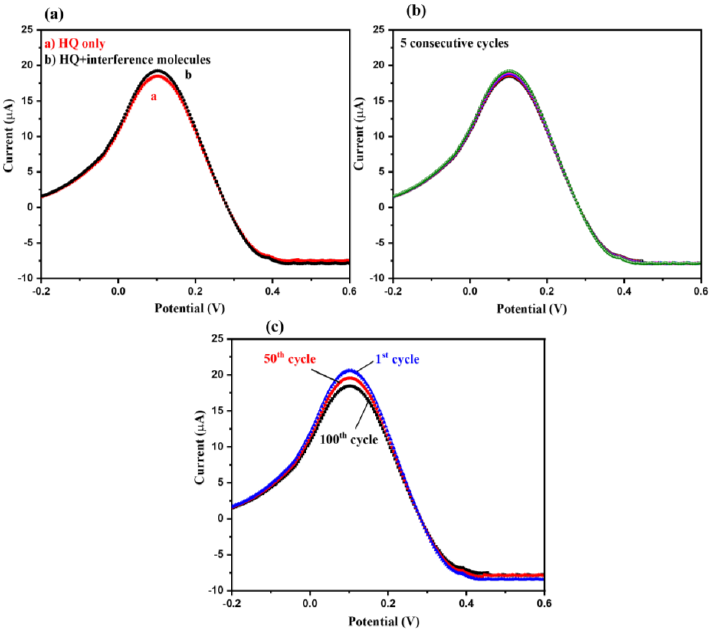
Figure 9. DPVs of CeO 2 /GCE. ( a ) Selectivity test: DPVs in presence of 15 µM HQ with (black) and without (red) interfering molecules (glucose, dopamine, H 2 O 2 , urea, uric acid, chlorophenol, nitrophenol, acetone, methanol, ascorbic acid, and hydrazine) at scan rate of 50 mV/s (concentration of interfering molecules was 5 times higher than that of HQ). ( b ) Repeatability test: 5 consecutive cycles of DPVs in presence of 15 µM HQ (scan rate = 50 mV/s). ( c ) Stability test: 1 st , 50 th , and 100 th DPV cycle in 75 µM HQ (applied scan rate = 50 mV/s).